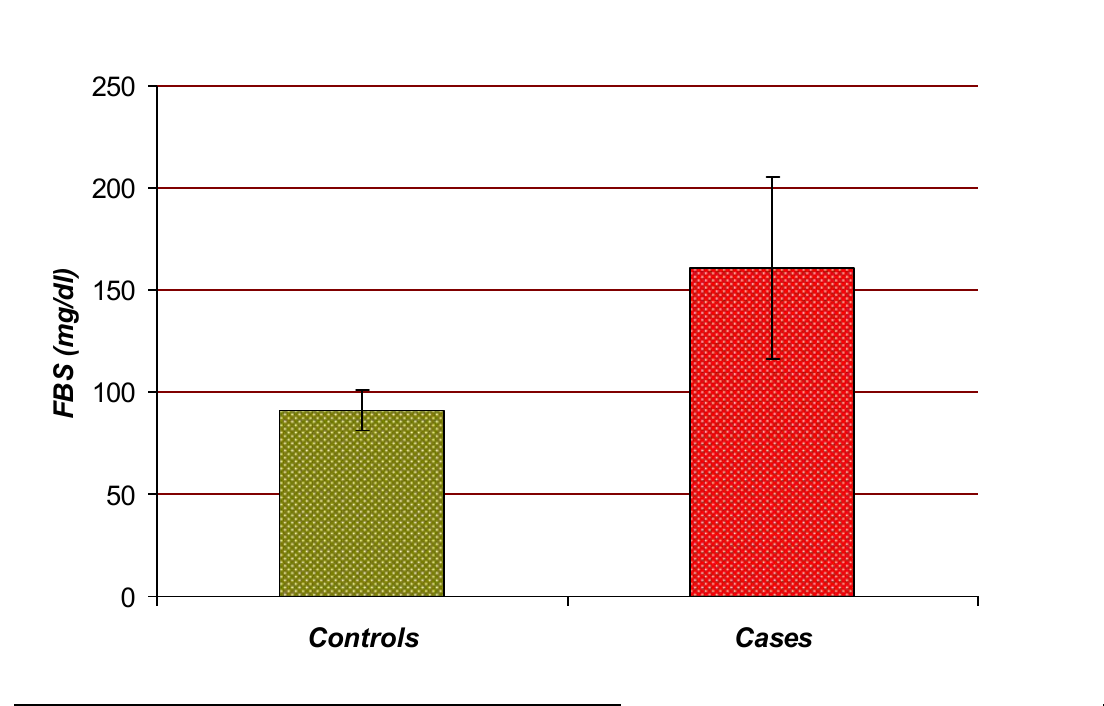
Figure 3: Comparison of levels of sugar parameters between controls and